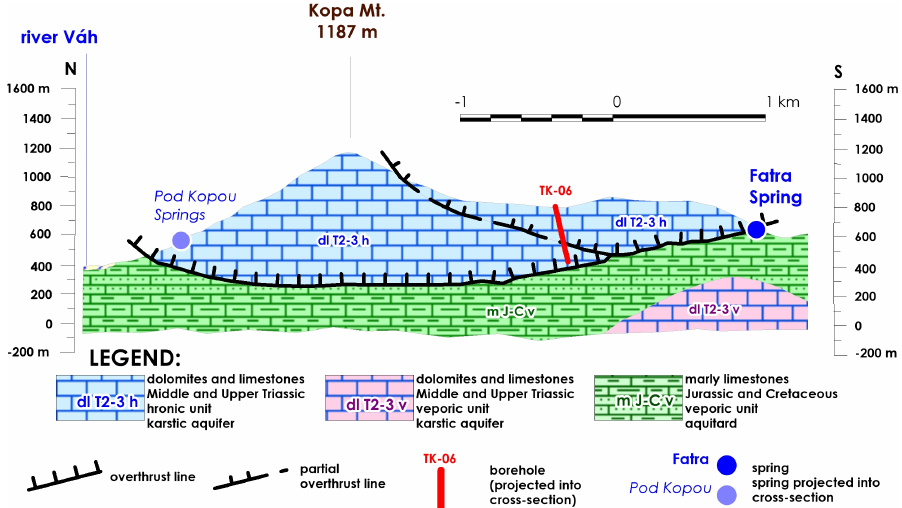
Figure 3. Simplified hydrogeological cross-section of the Kopa Mt. hydrogeological structure.